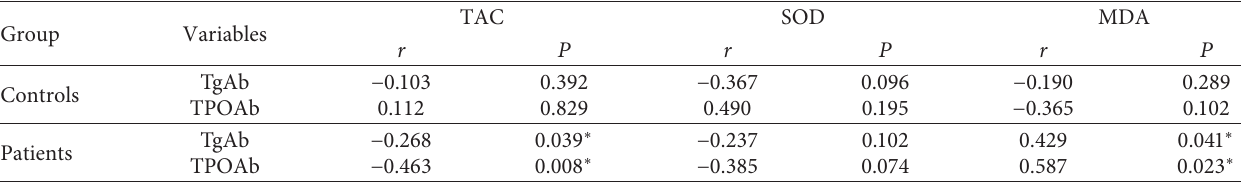
Table 4: Correlation analysis between the oxidative stress parameters and thyroid autoantibodies titers in pretreatment AIT patients and healthy controls. Group Variables Controls Patients